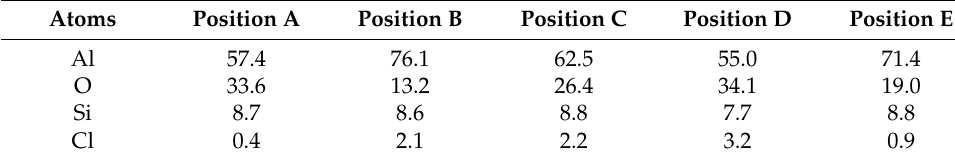
Table 7. EDS point scan analysis results of the typical positions in Figure 9